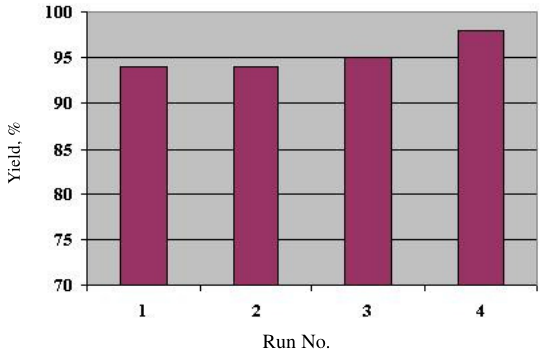
Figure 2. The reusability of the catalyst in the synthesis of 4- H -benzo[b]pyran4- H - benzo [b]pyrans ( 4c